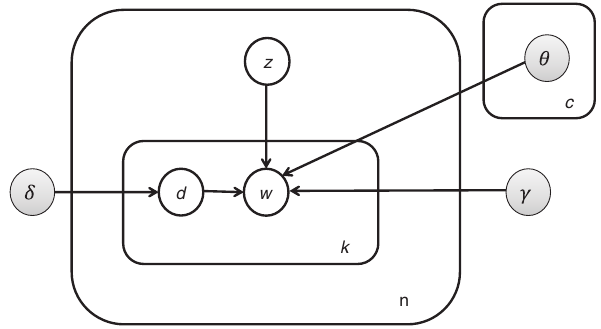
Figure 1: Proposed Model in Plate